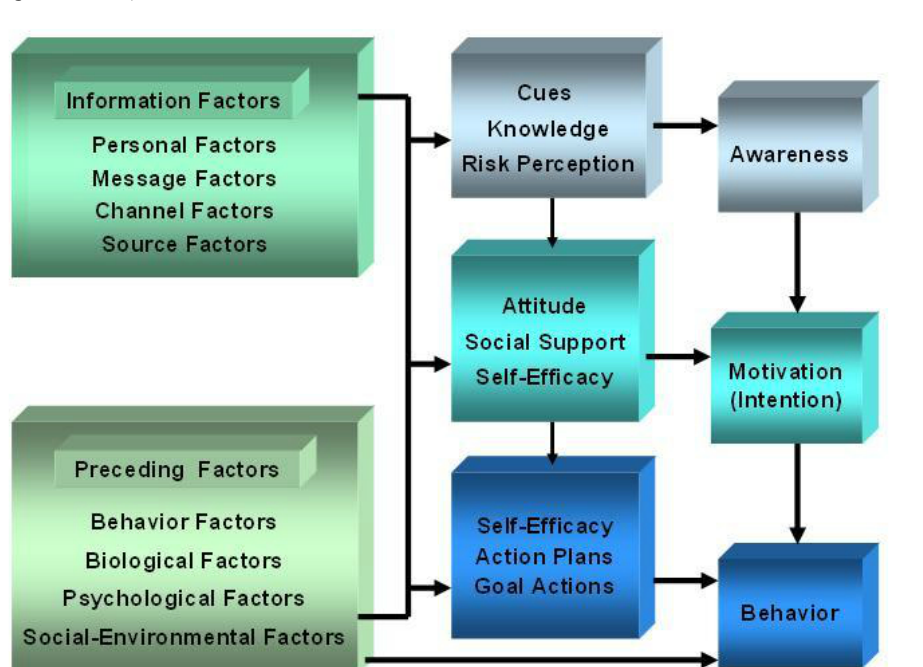
Figure 1. The I-Change Model